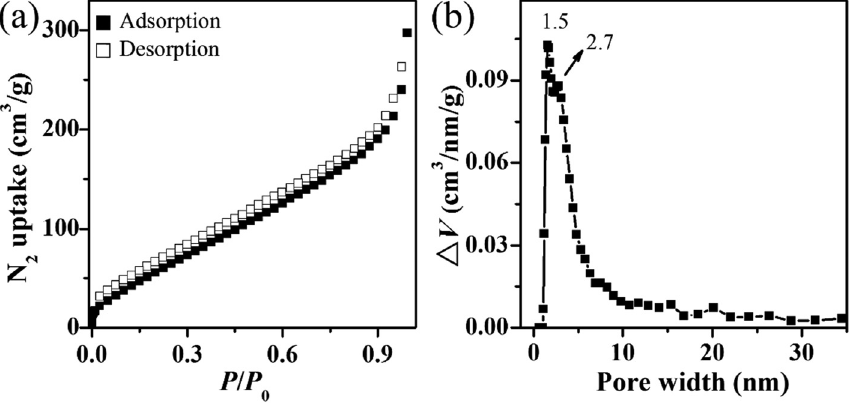
Figure 7: ( a ) Nitrogen sorption isotherms measured at 77 K and ( b ) the PSD plot fi tting by NLDFT to the sorption data of CTF –